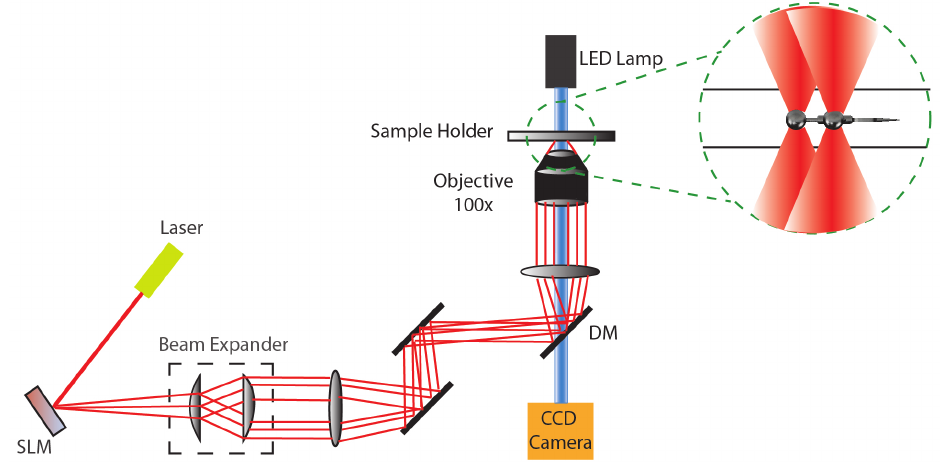
Figure 1. Optical trapping principle schematic along with integrated spatial light modulator (SLM) for multiple trap generation and